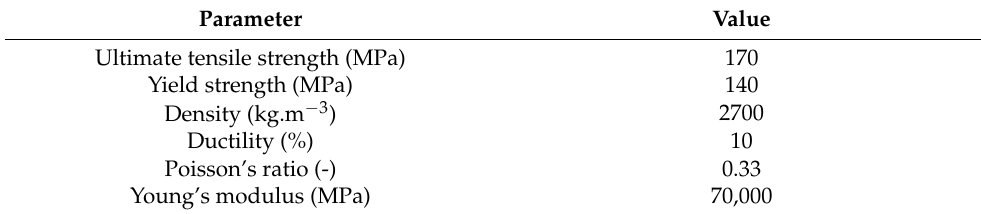
Table 5. Basic parameters of aluminium EN AW-6060 T6 [38]. Parameter